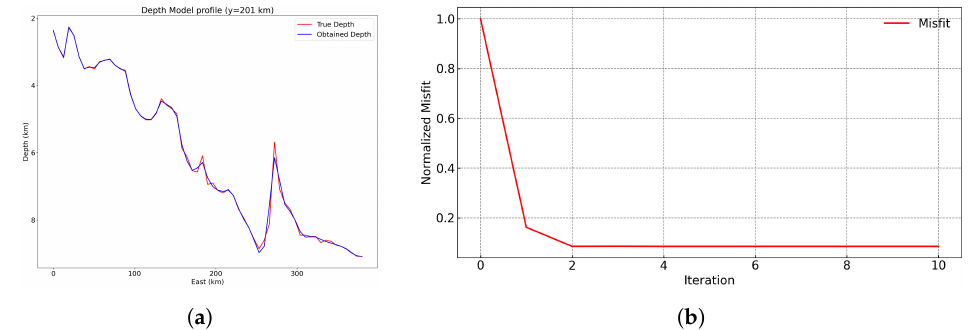
Figure 5. 1D profile along x -direction ( a ) for the true (red) and final (blue) depth model at y = 201 km. ( b ) The objective function cost (Misfit) is plotted for each iteration